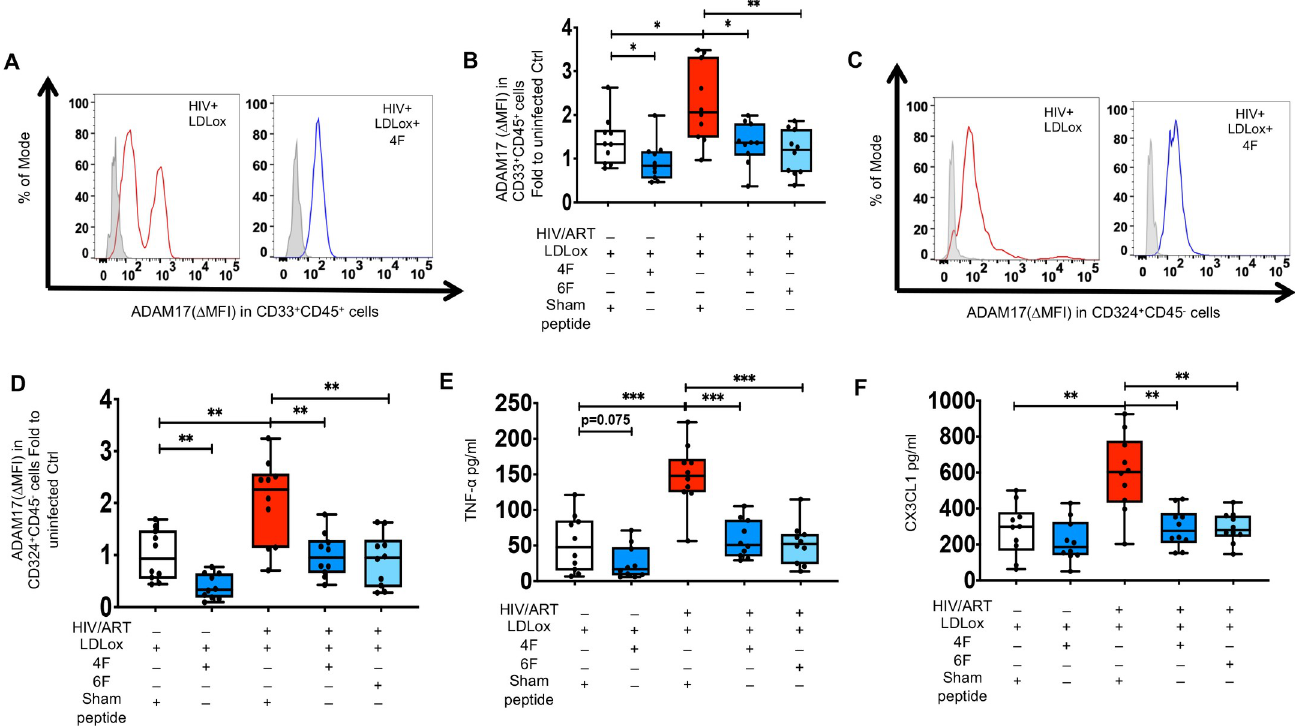
Fig 7. Ex vivo impact of ApoA-I mimetic peptides and oxidized low density lipoprotein (LDLox) on proteins levels of ADAM17 and associated cytokines and chemokines in gut explants of uninfected and HIV infected participants. Gut biopsies were obtained from uninfected (n = 10) and HIV infected participants on potent antiretroviral therapy (ART)(n = 10) and gut explants were treated with HDLox for 48 hours and 4F or 6F apoA-I mimetic peptides or sham peptide for 72 hours as in Materials and Methods. Gut biopsies from the same participants were used for experiments with treatments. A-D. Protein levels of A disintegrin and metalloprotease 17 (ADAM17) was detected in myeloid CD33 + CD45 + (A, B ) and CD324 + CD45 - epithelial cells (C, D ) isolated from gut biopsies obtained from uninfected and HIV infected participants treated as shown. A, C . Representative data of flow cytometry data of protein levels (Median fluorescence intensity) of ADAM17 against a negative stain control (fluorescence minus one control shown in light grey) are shown for myeloid CD33 + CD45 + (A ) and CD324 + CD45 - epithelial cells (C ). B, D. Summary data for protein levels of ADAM17 in intestinal myeloid CD33 + CD45 + ( B ) and CD324 + CD45 - epithelial cells ( D ) from gut biopsies treated as shown. E, F. Supernatants were collected at 72 hours and Luminex immunoassays were used to determine protein levels of cytokines [tumor necrosis factor alpha (TNF- α )]( E) and chemokines [C-X3-C Motif Chemokine Ligand 1 (CX3CL1)] ( F) , that are mediated by ADAM17 sheddase activity. Data represent box and whiskers with minimum, median and maximum values. Datapoints represent mean of 3 gut biopsies per participant. The Mann-Whitney test was used to compare 2 groups ( � p < 0.05, �� p < 0.01, ��� p <